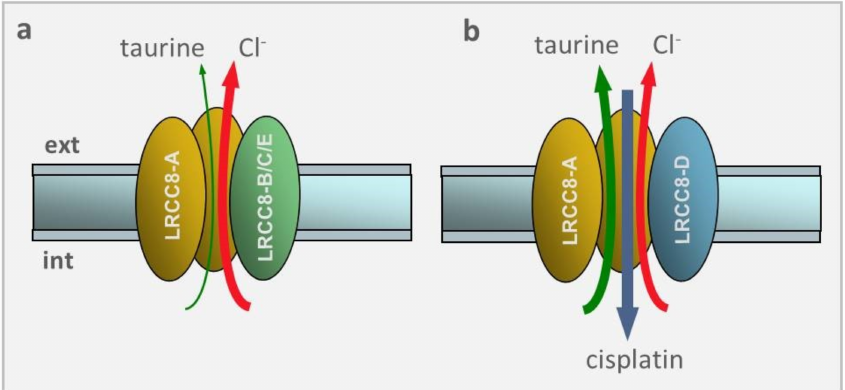
Figure 4. VRAC selectivity depends on the LRRC8 subunit composition. ( a ) VRAC made of the LRRC8A and LRRC8B/C/E subunits displays a large preference for Cl − ions over taurine, and no permeability towards cisplatin. ( b ) VRAC made of LRRC8A and LRRC8D subunits reverses